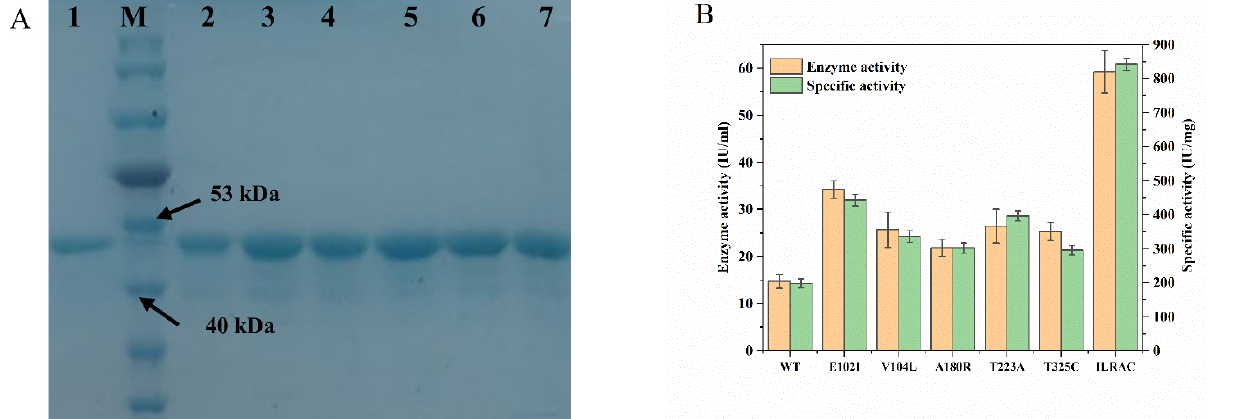
Figure 2. ( A ) SDS-PAGE analysis of BLASNase. M, protein molecular weight marker; lane 1, wild- type; lane 2, mutant E102I; lane 3, mutant V104; lane 4, mutant A180R; lane 5, mutant T223A; lane 6, mutant T325C; lane 7, mutant enzyme ILRAC (E102I/V104L/A180R/T223A/T325C). ( B ) Enzyme activity and specific activity of BLASNase.